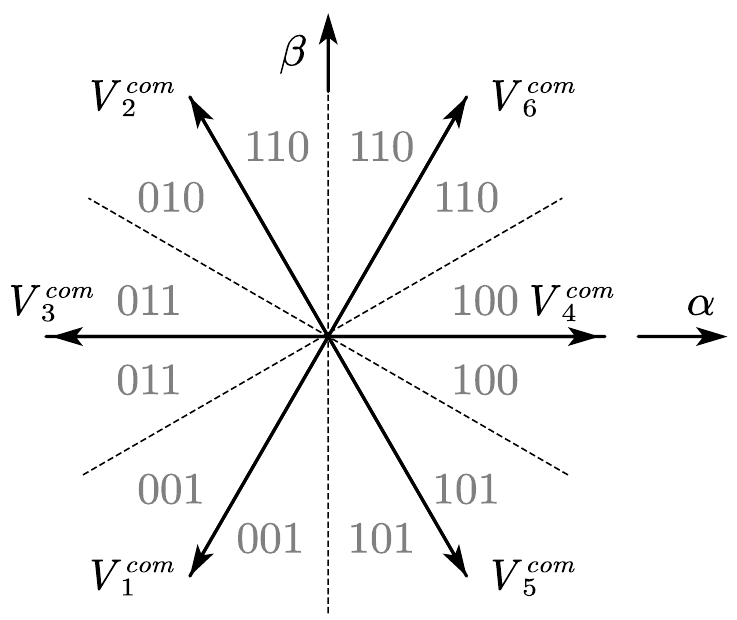
Figure 10. Relationship between θ and compensation voltage vectors. Table 1. Relationship between θ and three-phase stator current polarities.